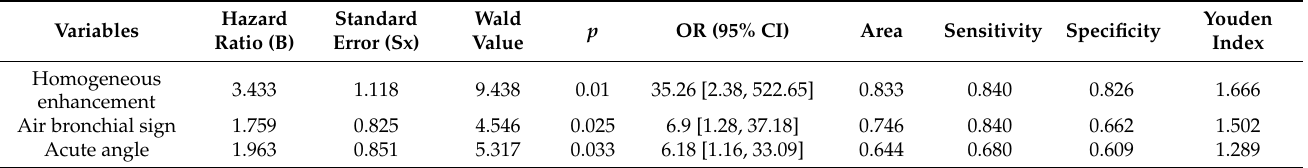
Table 4. Independent Predictors of FOP From Combined use of US and CEUS Based on Logistic